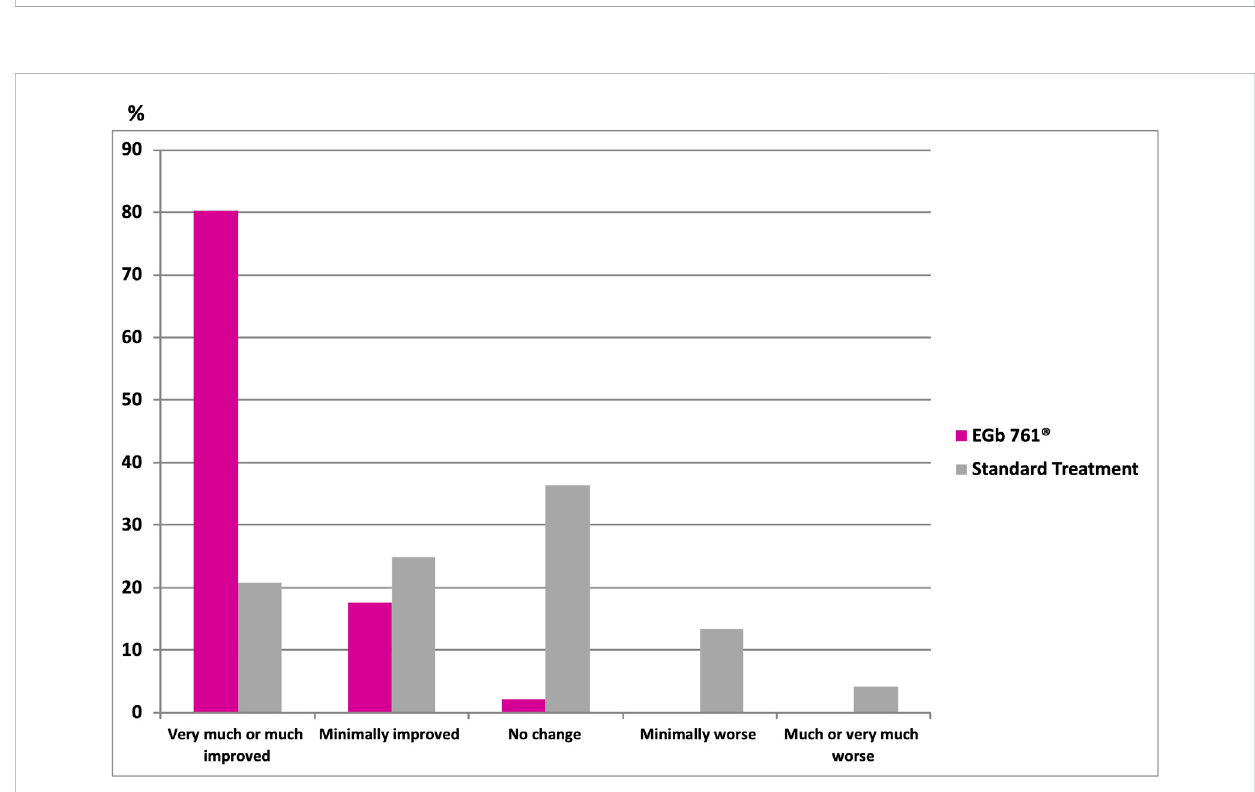
FIGURE 3 Clinical Global Impression of Change (CGI-C) at 24 weeks; p < 0.001 vs. standard (Fisher ’ s exact test